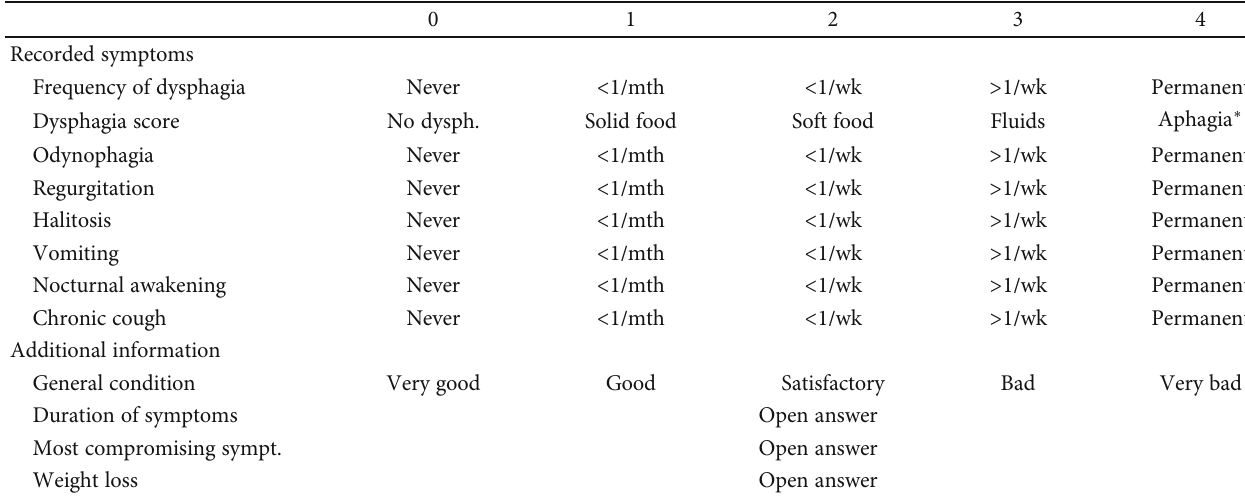
Table 1: Content of the questionnaire.